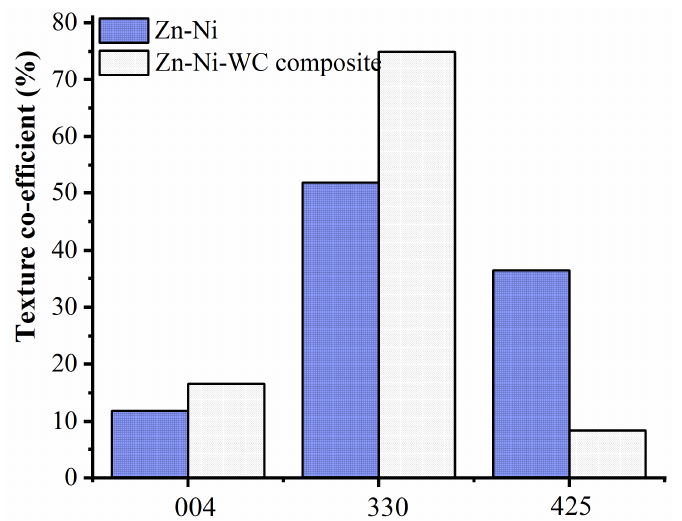
Figure 6. Texture coefficient (Tc) of Zn–Ni alloy and Zn–Ni–WC composites nanocoating.